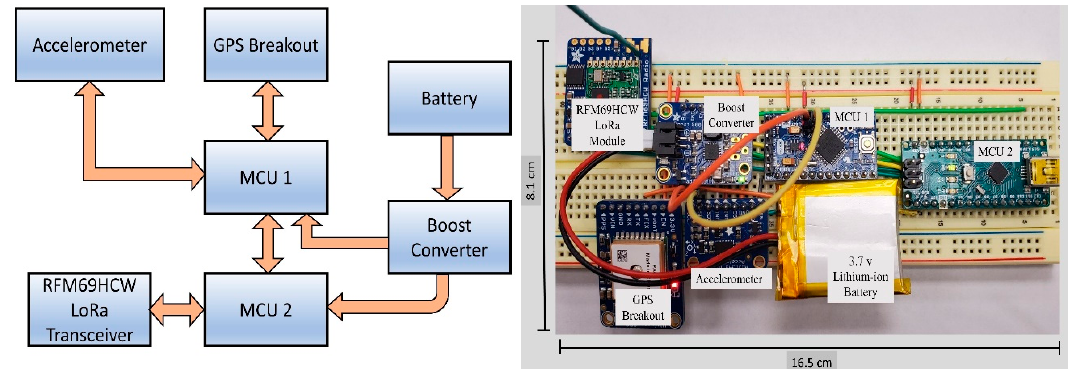
Figure 4. Architecture and prototype of the OBU